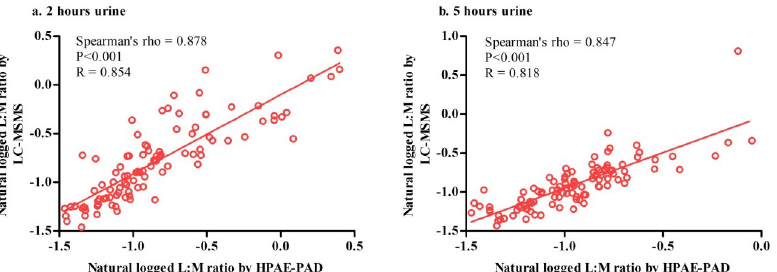
Fig 2. Correlation between 2 methods: HPAE-PAD and LC-MSMS. (a) 2 hours urine collection and (b) 5 hours urine collection. (a) 2 hours urine collection (n = 104); X axis indicates natural logged L:M ratio measured by HPAE-PAD; Y axis stands for natural loged L:M ratio measured by LC-MSMS (b) 5 hours urine collection (n = 104); X axis indicates natural logged L:M ratio measured by HPAE-PAD; Y axis denotes natural loged L:M ratio measured by LC-MSMS. R stands for linear reression value; Spearman’s rho stands for Spearman’s nonparametric correlations.